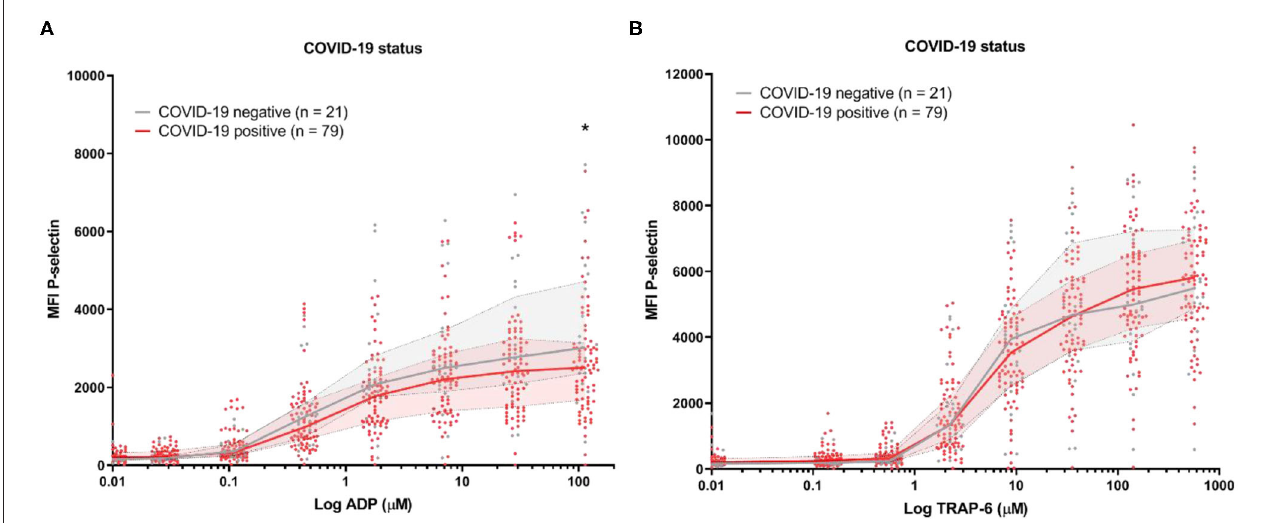
FIGURE 1 | Platelet reactivity of hospitalized COVID-19 positive patients and COVID-19 negative control patients with a different diagnosis. Median fluorescence intensity (MFI) of platelet P-selectin expression in response to ADP (A) , or TRAP-6 (B) . Data points represent individual values of COVID-19 positive patients ( n = 79; displayed in red) or COVID-19 negative control patients ( n = 21; displayed in gray). The median value and interquartile range are indicated. Statistical difference was tested for all concentrations of agonist using one-way ANOVA with Sidak’s multiple comparisons test. * p < 0.05.